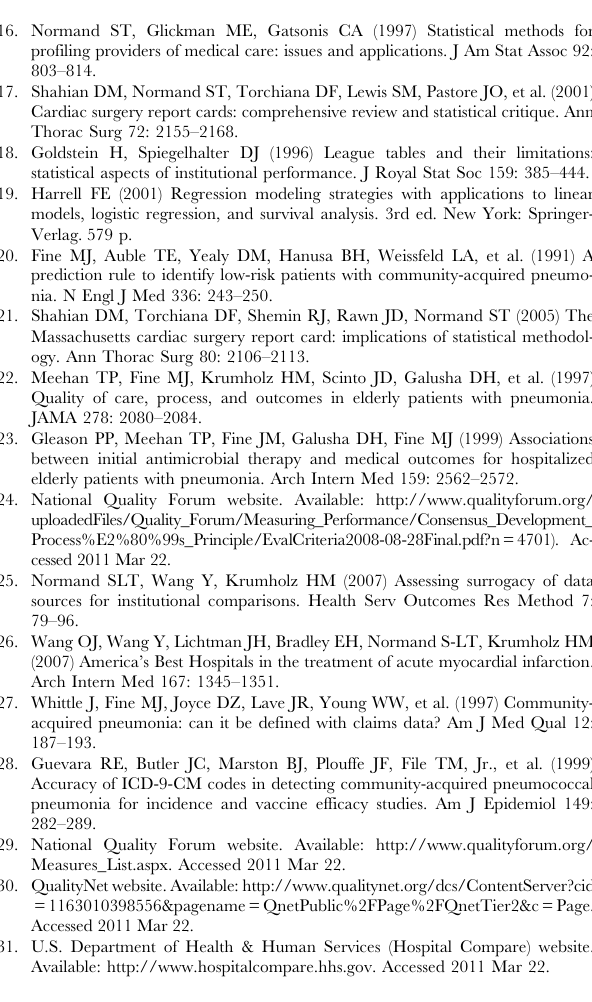
Table S1 Pneumonia study sample used for the derivation and validation cohorts.